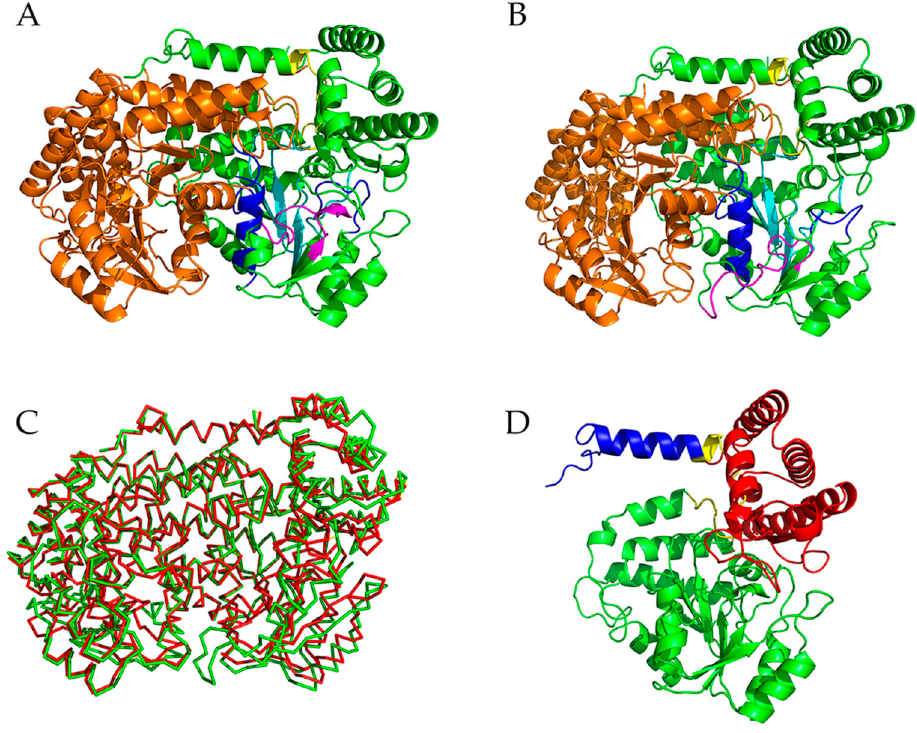
Figure 1. Cartoon representations of the crystal structures of two differently temperature-adapted serine hydroxymethyltransferases (SHMT) and their backbone superposition. ( A , B ) The dimeric forms of the mesophilic SHMT (mSHMT) from Escherichia coli (PDB ID: 1DFO [18]) and the psychrophilic SHMT (pSHMT) from Psychromonas ingrahamii (PDB ID: 4P3M [19]), respectively. ( C ) Backbone superposition of the two structures. ( D ) The monomeric form of mSHMT. The missing residues in the crystal structures were modeled as described in Section 4.1. In ( A , B ), the monomer-A and monomer-B are colored green and orange, respectively; the active-site components of the monomer-A, i.e., the “floor”, “walls”, and “roof” are colored cyan, blue, and magenta, respectively. In ( C ), the backbones of mSHMT and pSHMT are colored red and green, respectively. In ( D ), The N-terminal arm, large domain, small domain, and inter-domain linkers are colored blue, green, red, and yellow, respectively.